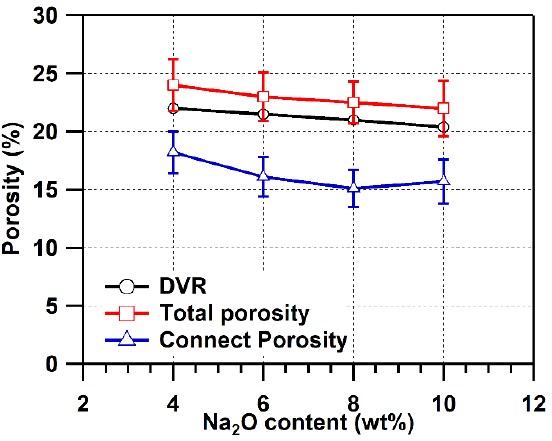
Figure 18. The DVR (designed voids ratio), total porosity and connect porosity of pervious concrete with paste of various equivalent Na 2 O content at 28 days.